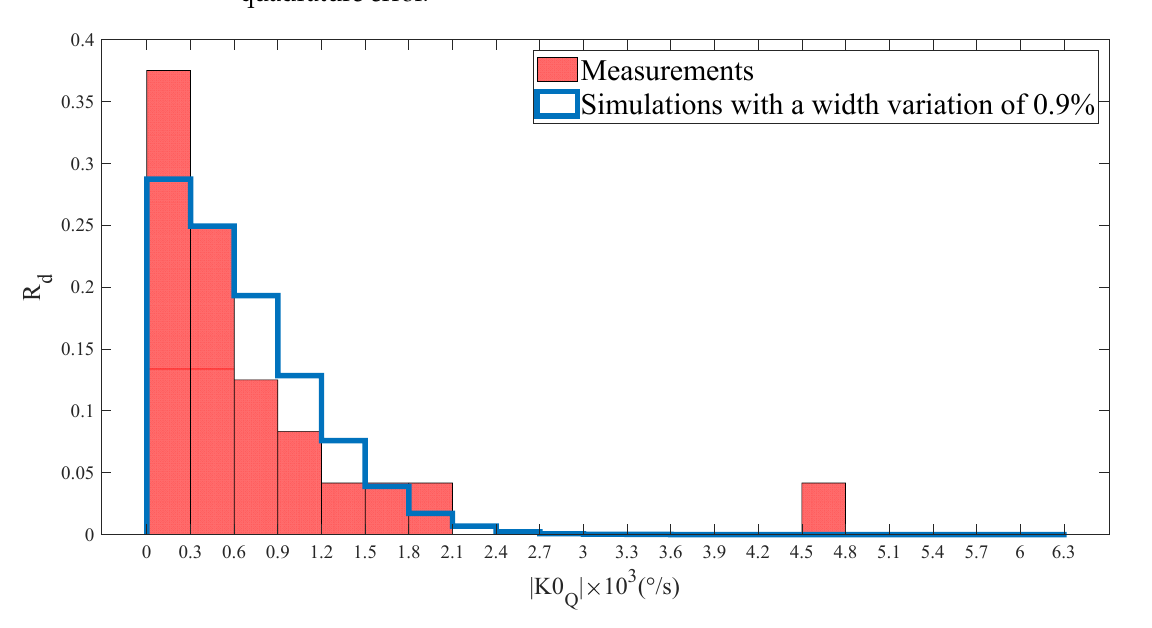
Figure 11. Comparison of the measurements of |𝐾0 (cid:3018) | with the simulations. 𝑅 (cid:3031) denotes the ratio of devices within a quadrature error interval to total number of devices.